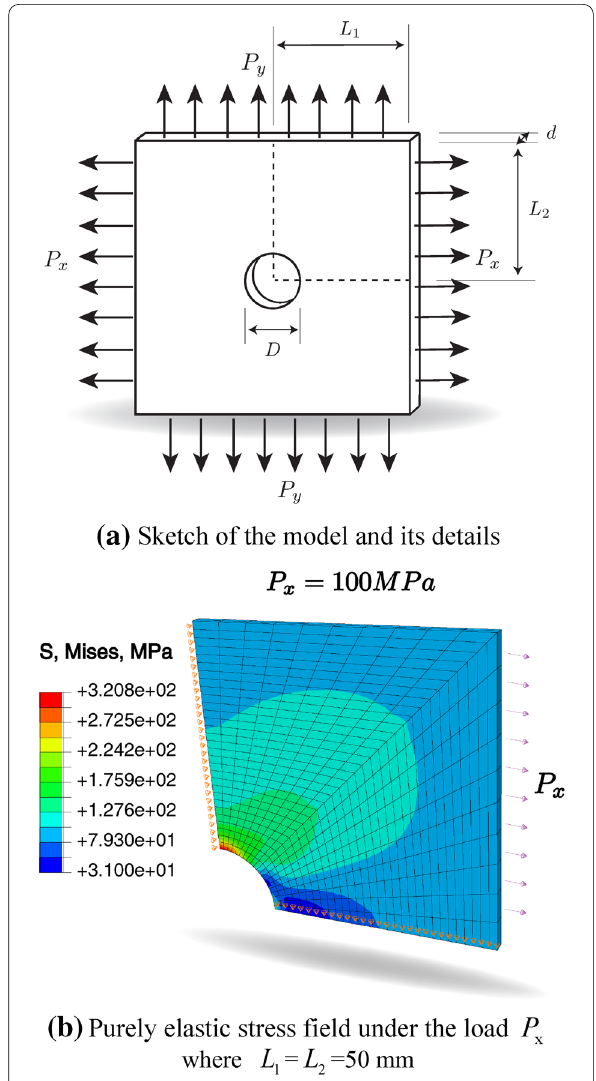
Figure 2 Sketch and elastic stress fields of plate with a circular central